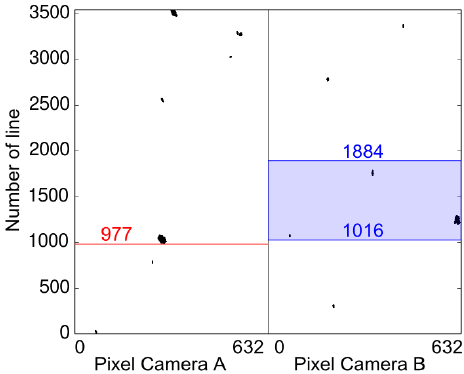
Figure 5. This example shows two raw camera streams. For the spe- cific snowflake hitting camera A at the red line, all possible match- ing partners in camera B are within the shaded